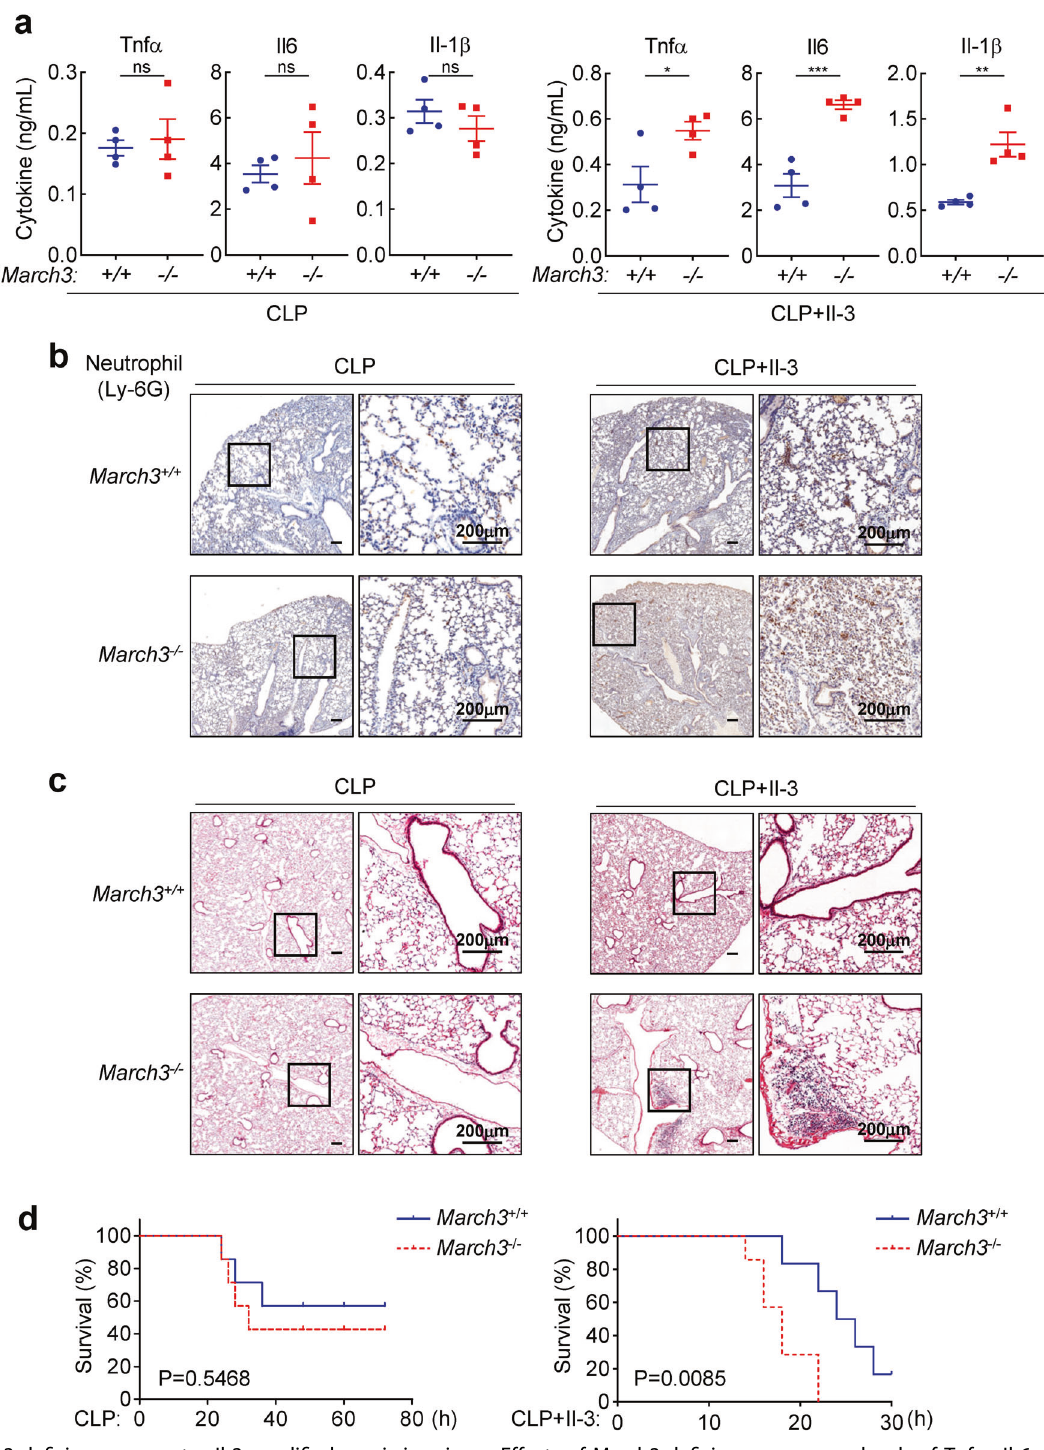
Fig. 6 March3-de fi ciency promotes Il-3-ampli fi ed sepsis in mice. a Effects of March3-de fi ciency on serum levels of Tnf- α , Il-6 and Il-1 β . Sex- matched and age-matched March3 + / + and March3 − / − mice were subjected to CLP and then injected via tail vein with Il-3 (3 μ g each mouse) or PBS for 4 h before measurement of serum cytokines by ELISA. Results are represented as mean ± SEM, n = 4. * P < 0.05, ** P < 0.01, *** P < 0.001; ns not signi fi cant. b , c IHC and H&E staining of lung tissues. The mice were subjected to CLP and injected twice with Il-3 (3 μ g each mouse) or PBS via tail vein at 30 min and 12 h after CLP. Mice were sacri fi ced at 24 h after CLP for IHC staining with Ly-6G ( b ) or H&E staining ( c ). d Effects of March3-de fi ciency on CLP-induced death of mice. For the left graph, March3 + / + and March3 − / − mice ( n = 7 for each group) were subjected to CLP, and the survival of mice was monitored every 2 h. For the right graph, March3 + / + ( n = 6) and March3 − / − ( n = 7) mice were subjected to CLP and injected twice with Il-3 (3 μ g each mouse) via tail vein at 30 min and 12 h after CLP. The survival of mice was monitored every 2 h. The survival curves were generated by Kaplan – Meier methods followed by log-rank test